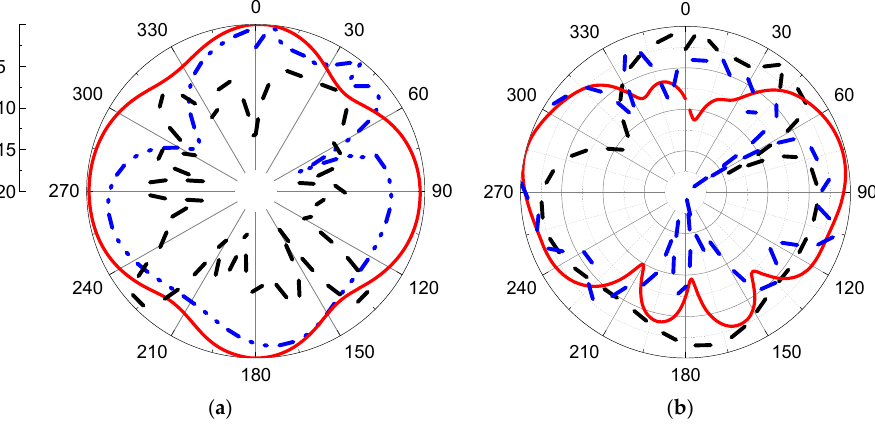
Figure 16, Radiation pattern for proposed antenna with and without breast model ( a ) φ = 0°, ( b ) φ = 90°. Red line: simulated without phantom, black dashed line: simulated with phantom, and blue dash\ ‐ dot line: measured without phantom at 2.1 GHz.